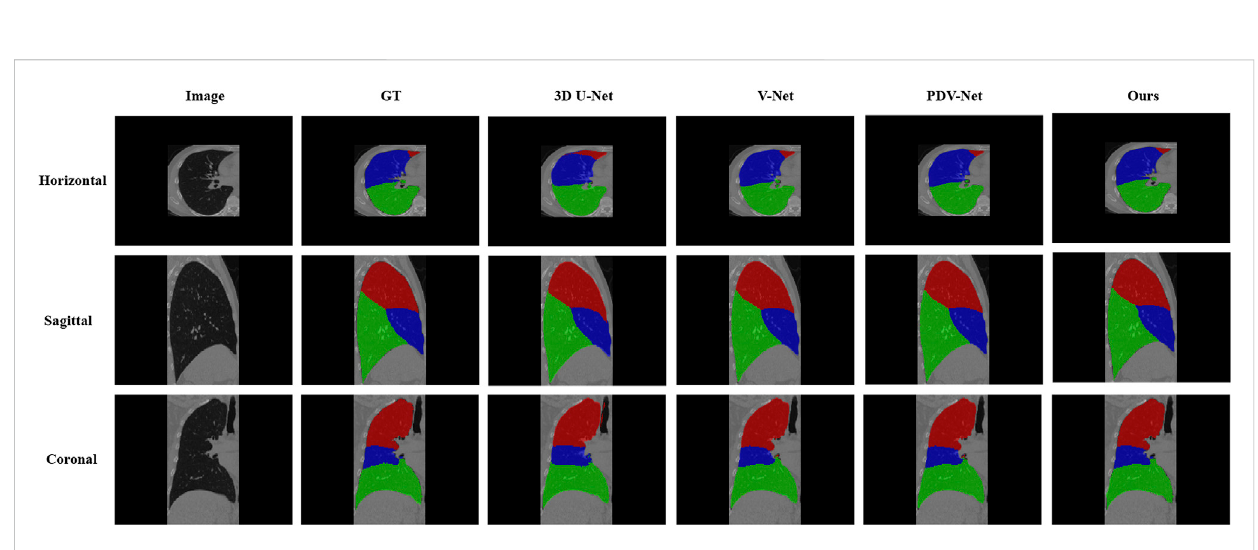
FIGURE 6 Visualcomparisonbetweenourproposedmodeland3DU-Net,V-Net,PDV-Netandgroundtruth;This fi gureshowsthesegmentationresultsofthecross section, sagittal plane and coronal plane of the right lung region; Color Coded, Red: Right Upper Lobe; Blue: Right Middle Lobe; Green: Right Lower